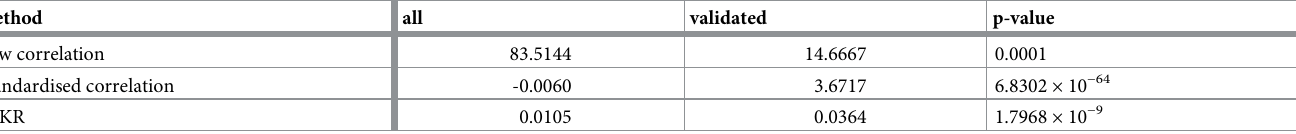
The mean score for validated links using the raw strain correlation score is in fact lower than the mean for all potential links, while for both standardised strain correlation score and IOKR, the mean for validated links is higher than the mean for all potential links. Note that the scores are not guaranteed to be on the same scale, so they are not directly